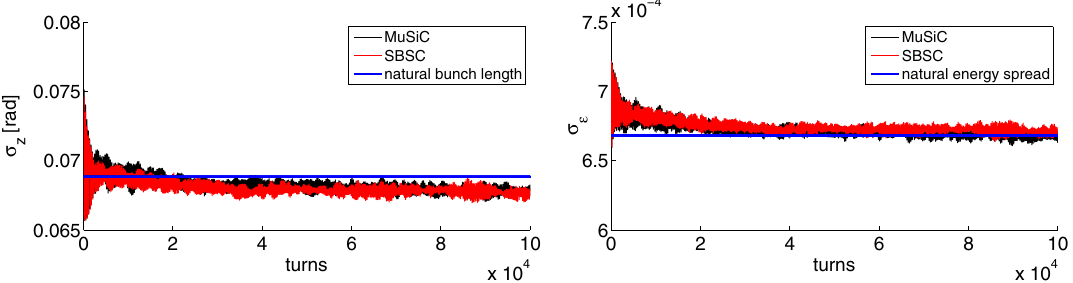
FIG. 14. Comparison of the rms bunch length (right) and energy spread (left) as a function of number of turns in the potential well distortion regime between M U S I C and the single bunch simulation code SBSC for the longitudinal impedance of the PS